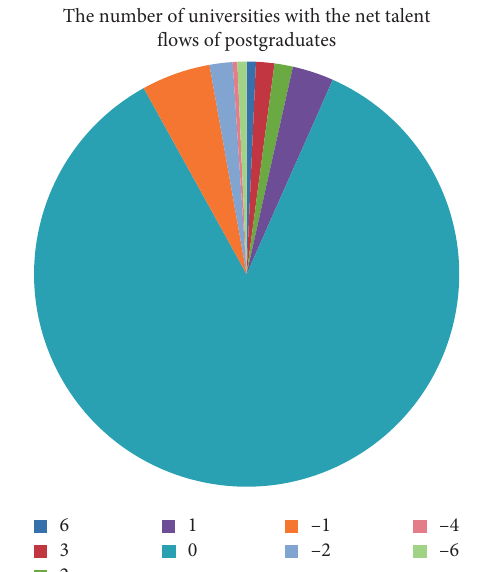
Figure 3: The distribution of net talent flows of postgraduates.